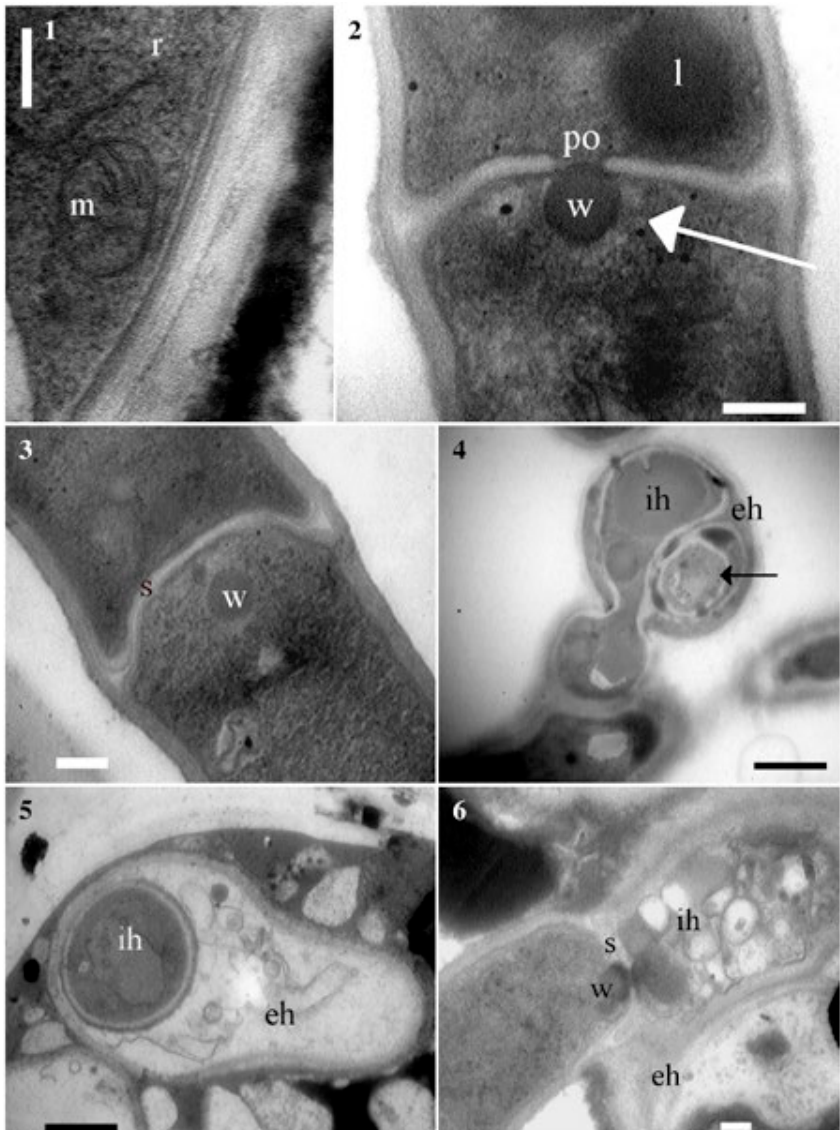
hyphal plug occludes the pore. (fungal structures: eh, external hypha; ih, intrahyphal hypha; l, lipid droplet; m, mitochon